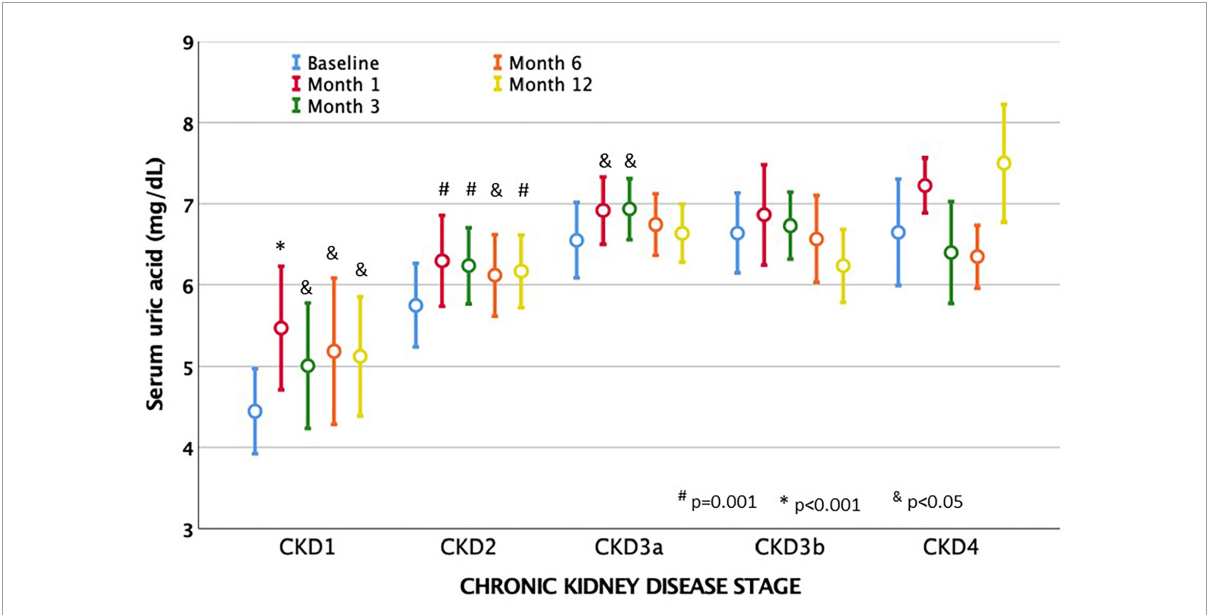
FIGURE5 Evolution of mean serum acid uric levels after treatment with tolvaptan and chronic kidney disease stages (CKD). Acid uric levels increased from the first month of taking tolvaptan in all stages, but especially in patients con eGFR, which is more preserved. Baseline levels of uric acid gradually increased as eGFR dropped. Mean values and mean standard errors are